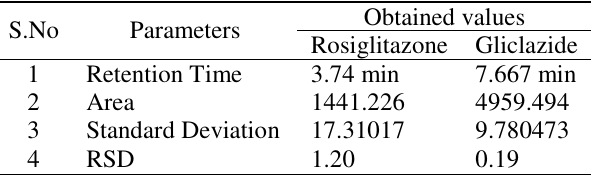
Figure 2. Linearity graph of rosiglitazone. Figure 3. Linearity graph of gliclazide. Table 1. System suitability.